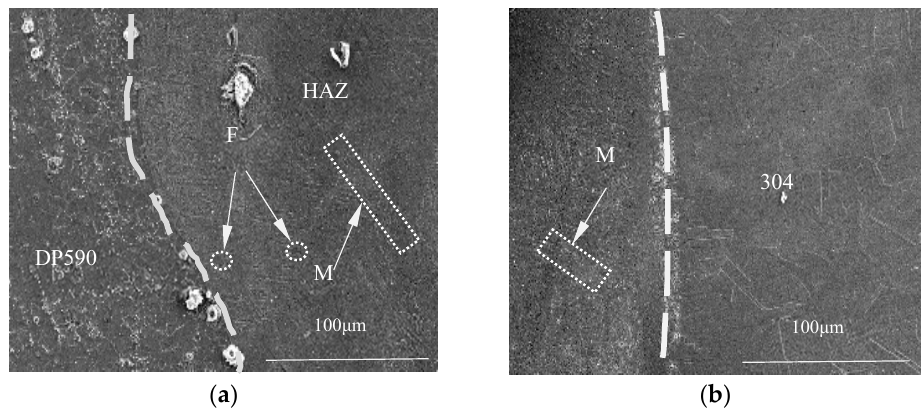
Figure 4. Microstructure of the boundary zones of the welded joint without the nickel coating: ( a ) near the DP590; ( b ) near the 304.